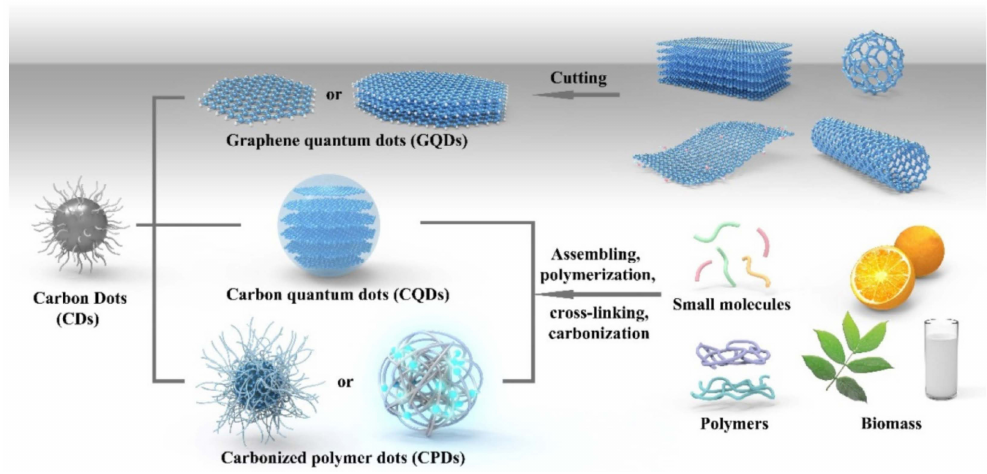
Figure 1. Different fabrication approaches of GQDs, CQDs, and CPDs. Reproduced with permission from ref.